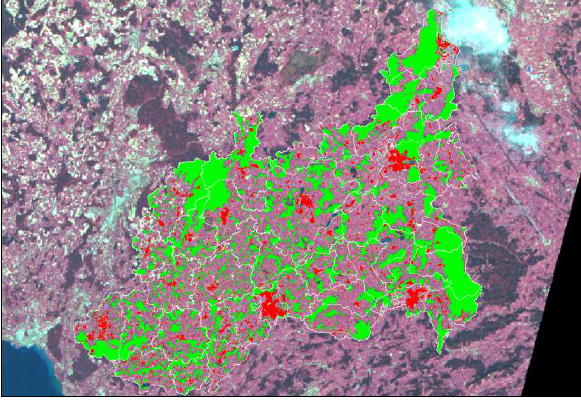
Figure 2. IRS-1C image with topographical GIS vector data